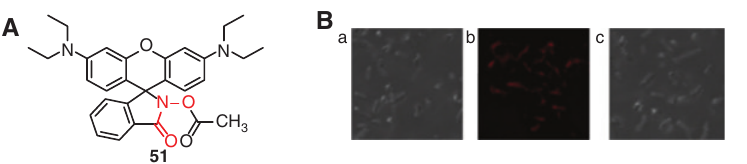
Figure 34: (A) Structure of probe 51 and (B) laser confocal scanning microscopy experiments. Reprinted from Hu et al. (2011).